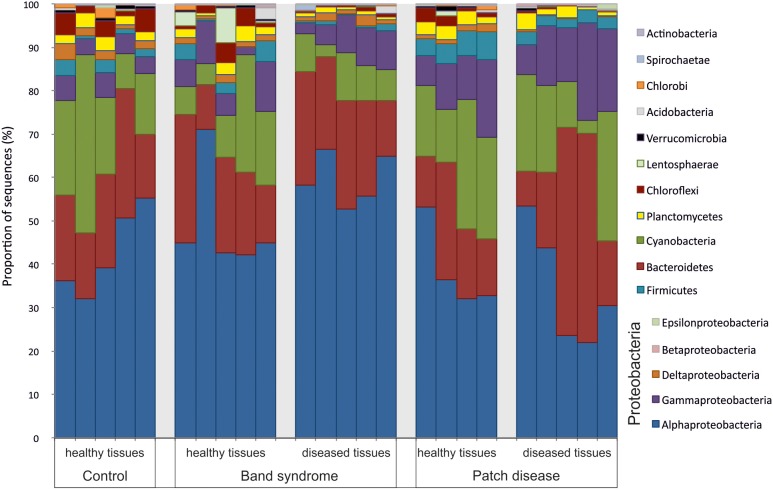
Bacterial community composition at the phylum level in healthy and diseased N. mamillare tissues based on 16S rRNA sequences. The most abundant phylum are shown (>0.1% of the sequences).